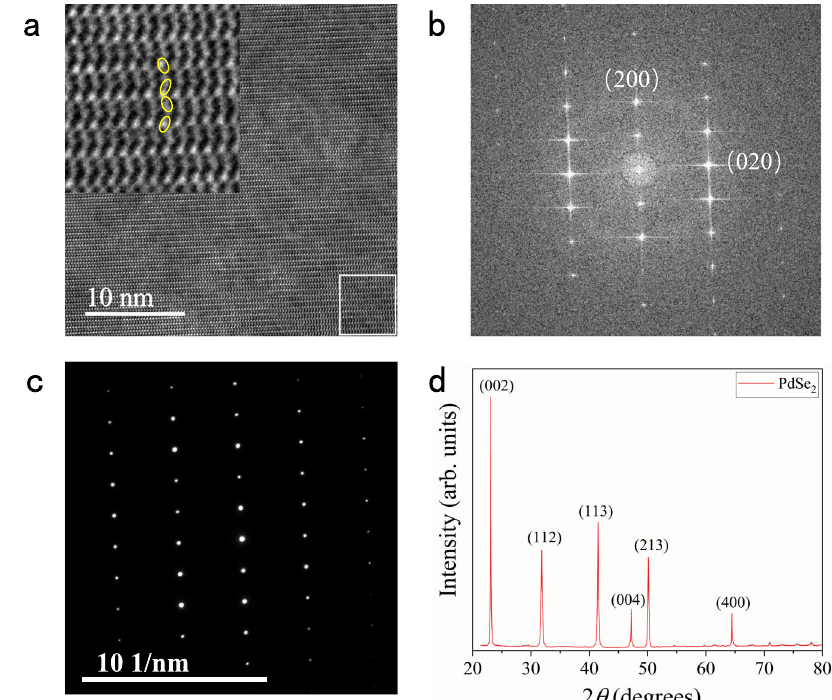
Fig. 2 TEM and XRD characterizations of PdSe 2 fl akes. a HRTEM image of the few-layer region of PdSe 2 fl akes. The inset shows a zoom-in of the white square regions, revealing the atomic models. The scale is marked in the lower-left corner. b FFT diffraction patterns of the solid white areas highlighted on the image ( a ). c SAED pattern of the PdSe 2 . d XRD pattern of bulk PdSe 2 is in good agreement with the standard PDF card (PDF#97-017-0327). The diffraction pattern exhibits six robust peaks at 23.1, 31.8, 41.5, 47.2, 50.14, and 64.4°,